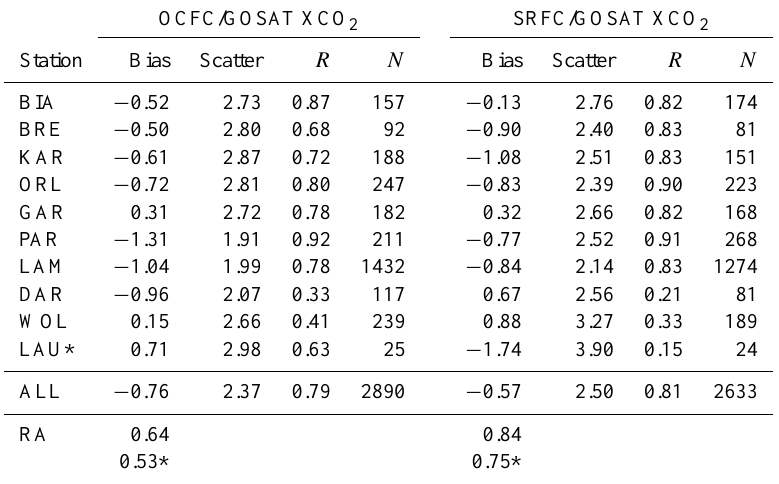
Table 5. OCFC and SRFC XCO 2 validation results for all individual stations and using all data combined (ALL). All results apart from R and N are inppm units. Stations flagged by * have been excluded from the relative accuracy calculation (equally flagged by